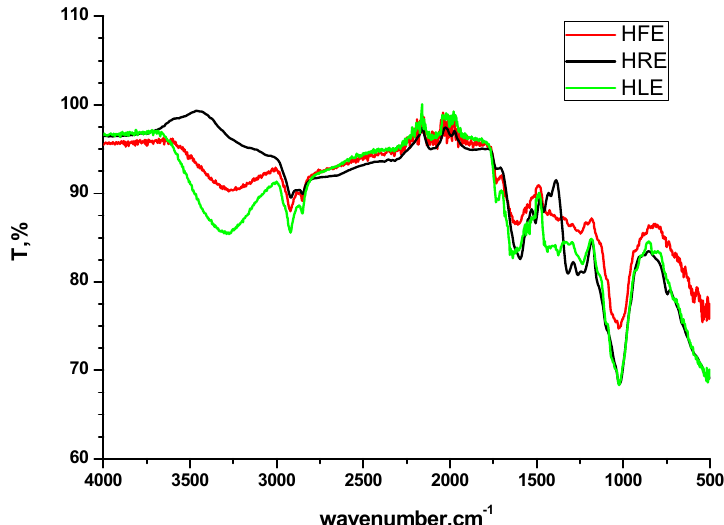
Figure 12. FTIR spectra of the extracts of Harmal roots (HRE), Harmal leaves (HLE), and Harmal flowers (HFE).